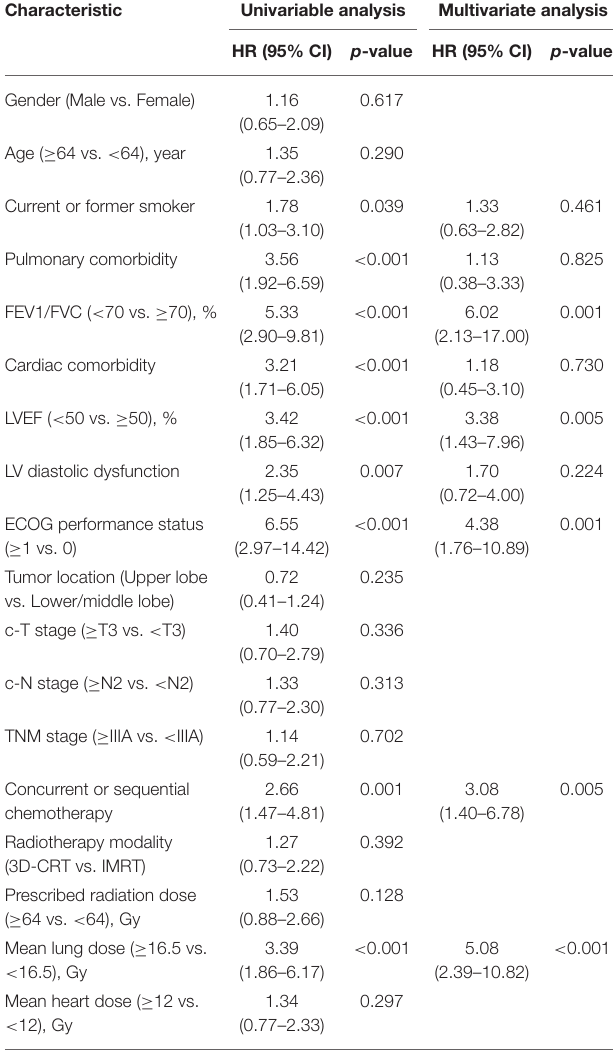
TABLE 2 | Univariate and multivariate logistic regressions analysis for grade ≥ 2 radiation pneumonitis. Characteristic Univariable